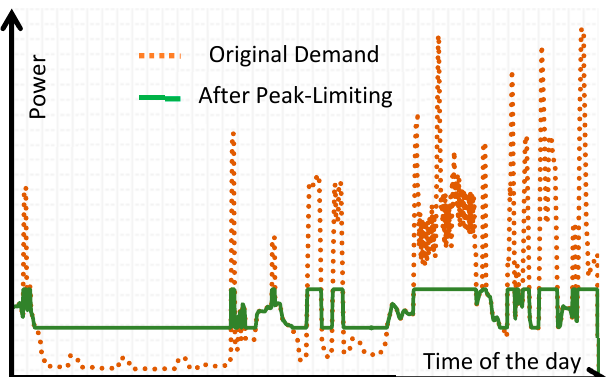
Figure 4. Illustration of voltage support on a fictive feeder.